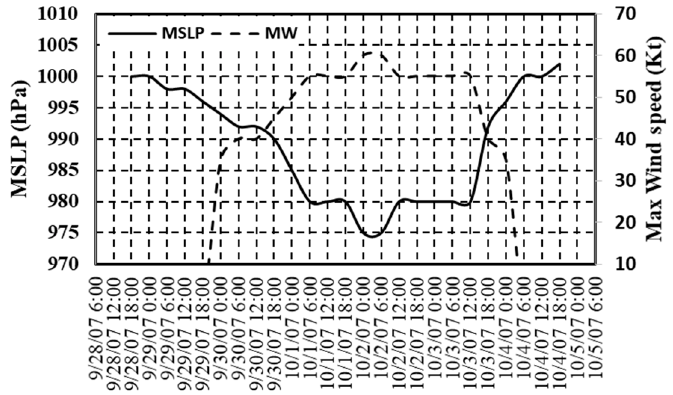
Figure 1. Minimum sea level pressure (MSLP) and maximum sustained wind speed of Typhoon Lekima in 2007.